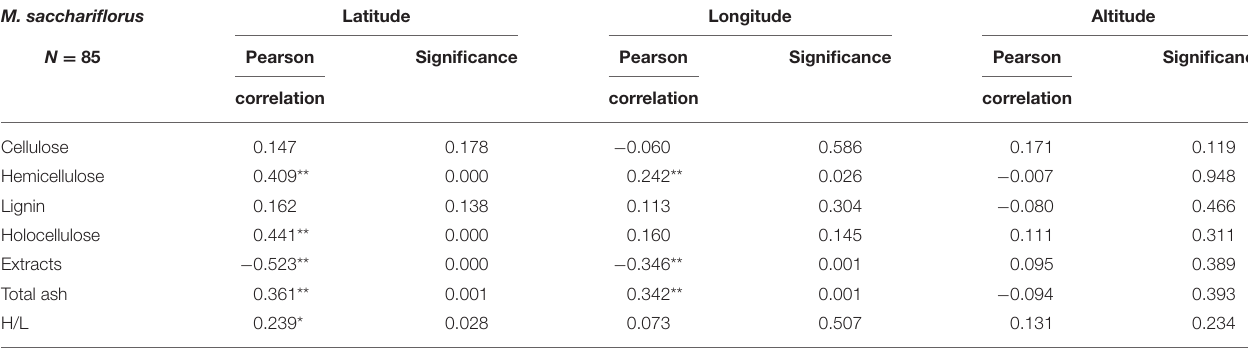
TABLE 4 | Correlation analysis between lignocellulose content and geographical distribution of M. sacchariflorus